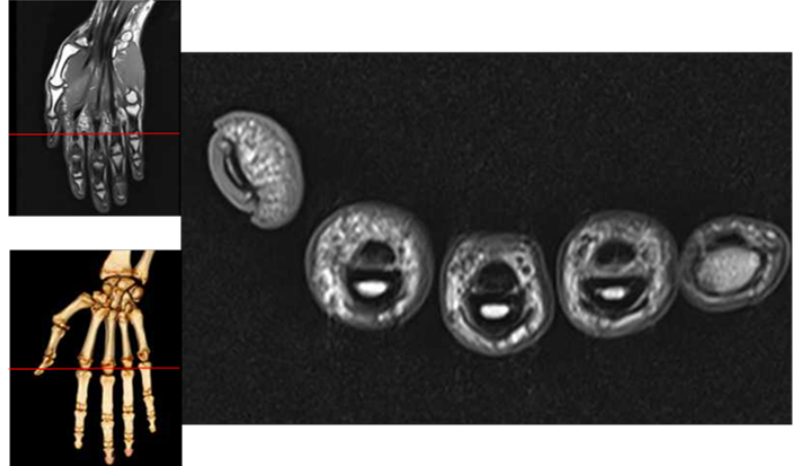
Figure 3. Cross-sectional MRI of the finger.